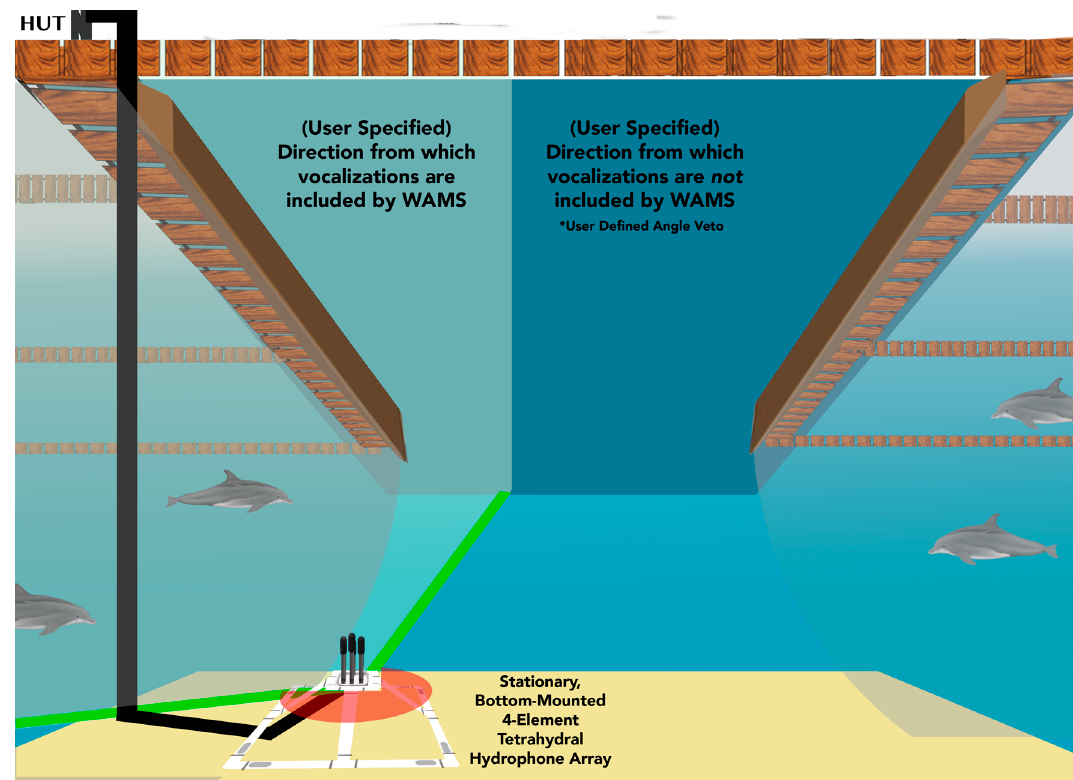
Figure 2. Underwater schematic of the bottom-mounted hydrophone array deployed at the MMP. The two natural seawater enclosures are separated in the center by a 10 m wide channel which separates two groups of dolphins. The angle veto in WAMS excludes whistle detections that originate outside of the delineated range.